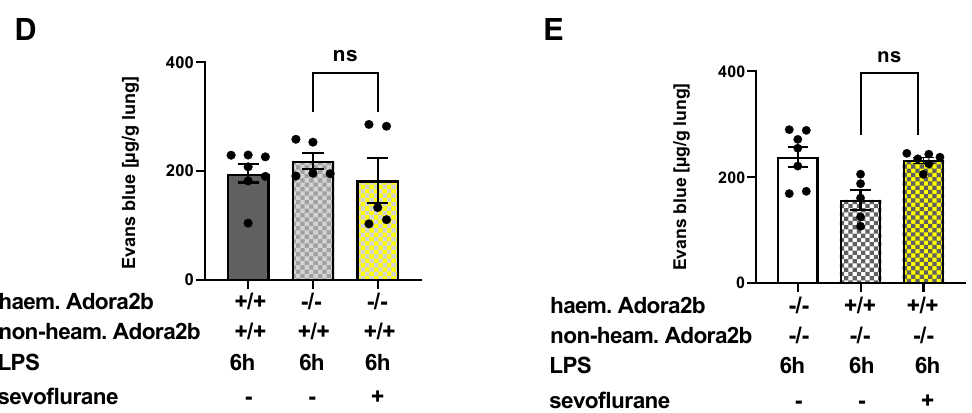
Figure 6. Contribution of sevoflurane on hematopoietic and non-hematopoietic cells to lipopolysac- charide (LPS)-related polymorphonuclear neutrophil (PMN) migration and microvascular perme- ability. ( A ) We generated chimeric mice by transferring bone marrow (BM) between wild-type (Adora2b+/+) and adenosine A2B receptor − / − (Adora2b − / − ) animals to characterize the cell types, which contributed to the sevoflurane-related protective effects. Bone marrow transfers were performed: (1) BM from Adora2b − / − mice were injected into wild-type recipients (chimeric